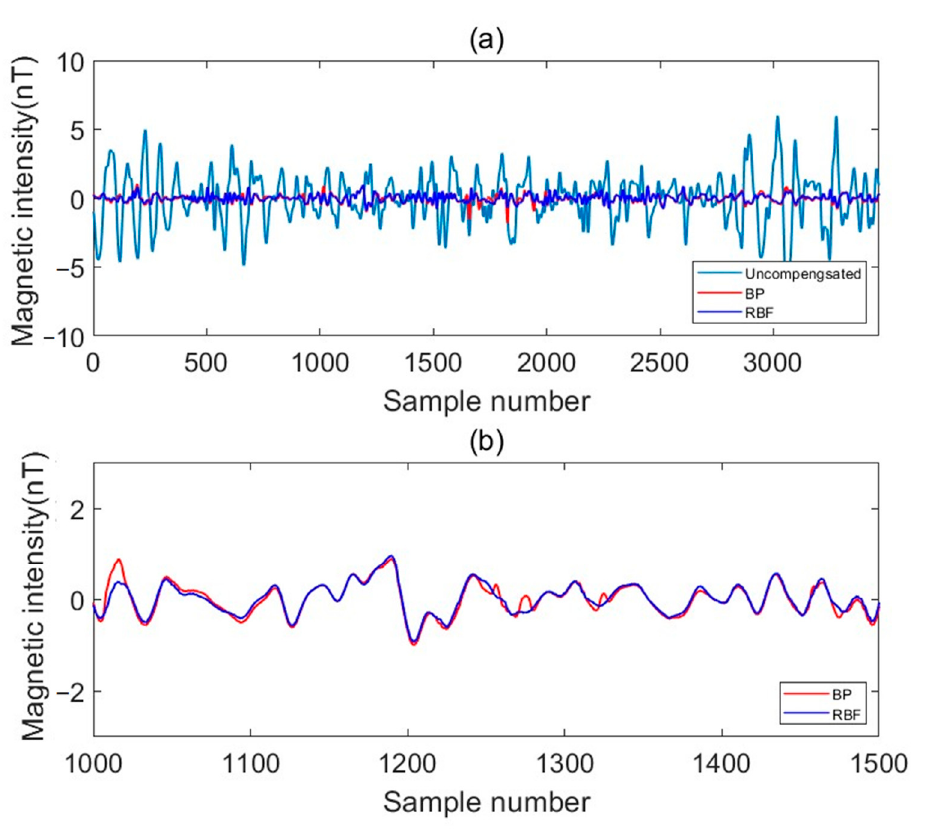
Figure 12. Flight C compensation results: ( a ) BP-ANN and BRF-ANN compensation results; and ( b ) compensation for the resulting sampling points 1000 to 1500. Table 3. Comparison of compensation results of BP-ANN and